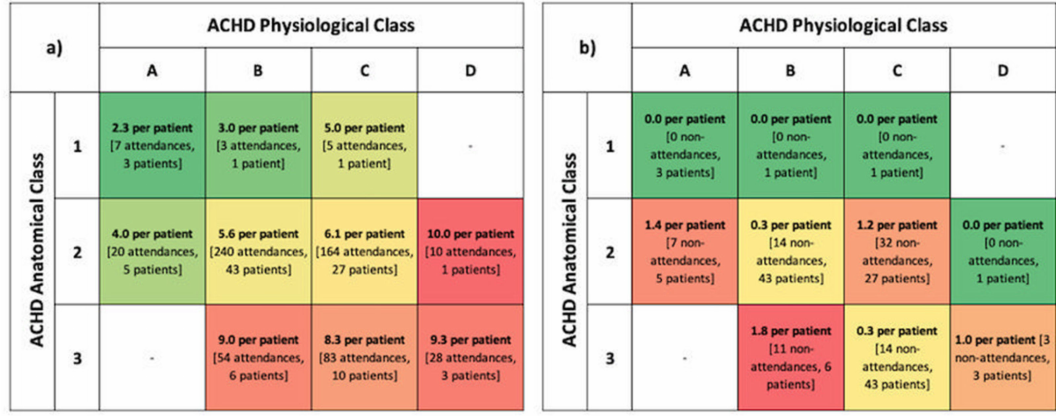
Figure 2. ( a ) Mean attendances and ( b ) nonattendances per patient during study period according to ACHD AP